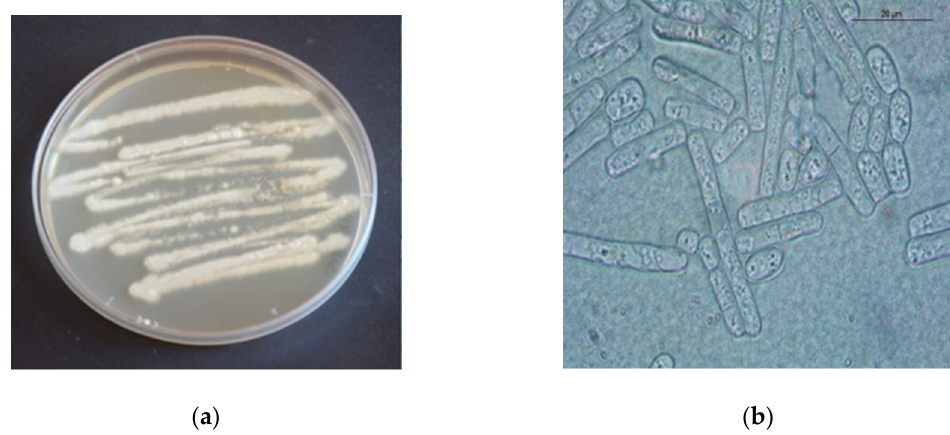
Figure 3. Macroscopic ( a ) and microscopic ( b ) features of Geotrichum candidum . ( a ): White, dry, powdery to cottony colonies of Geotrichum candidum . ( b ): Hyaline septate hyphae breaking up into chains of hyaline, smooth, one-celled, sub-globose to cylindrical arthroconidia (6–12 × 3–6 µm in size).